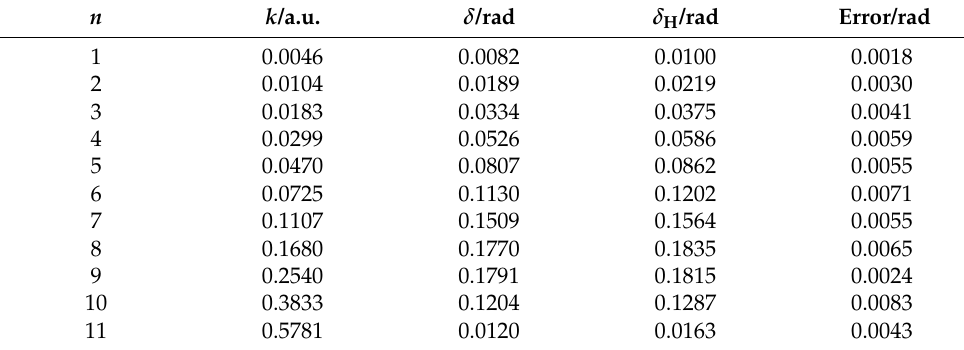
Figure 7. Positron–hydrogen s -wave scattering phase shifts obtained using nine nonzero γ i terms in the wavefunction with various α i , β i and γ i values (red circles). Details of the parameters used in this wavefunction can be found in Appendix B. Pink circles connected by the dashed line are calculations of Humberston et al. [24]. Table 2. Results from positron–hydrogen s -wave phase shift calculations with nine γ i (cid:54) = 0 terms in the wavefunction (see Appendix B) for the first 11 energy eigenvalues E n . The phase shifts of Humberston et al. [24] δ H interpolated to the same values of k are also shown. n k